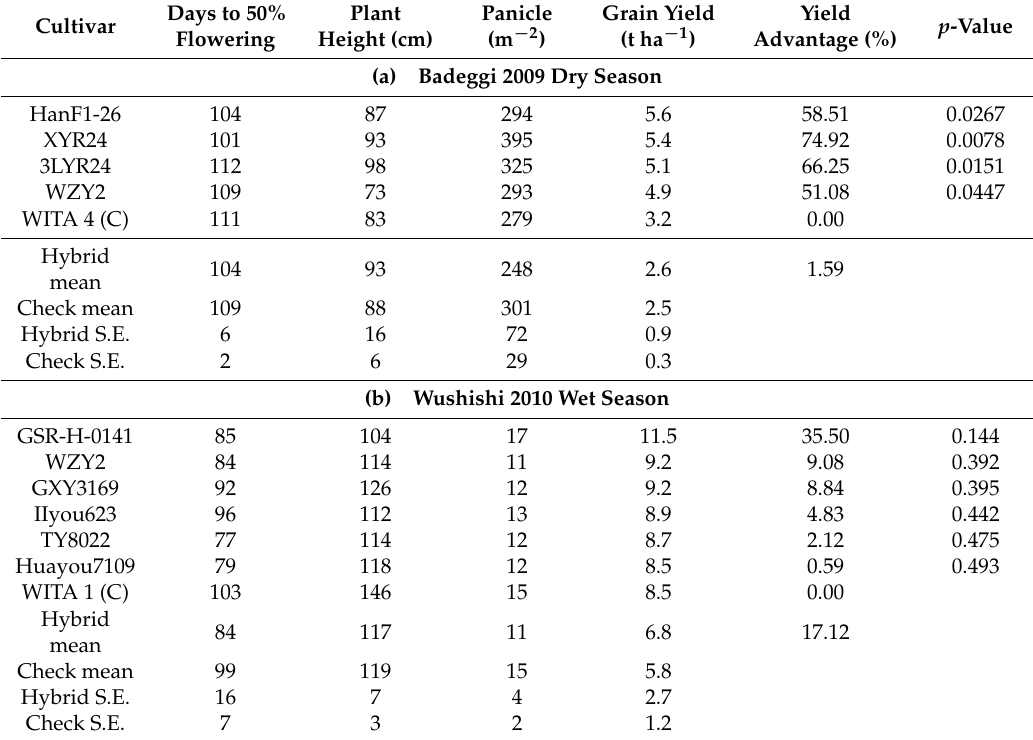
Table 4. Grain yield and other agronomic traits of promising rice hybrids and best cultivar check (C) at ( a ) Badeggi 2009 dry season and ( b ) Wushishi 2010 wet season. The p -value indicates that the hybrids’ yield was higher that WITA1 and WITA4. Standard errors (S.E.) given for each trait. Cultivar